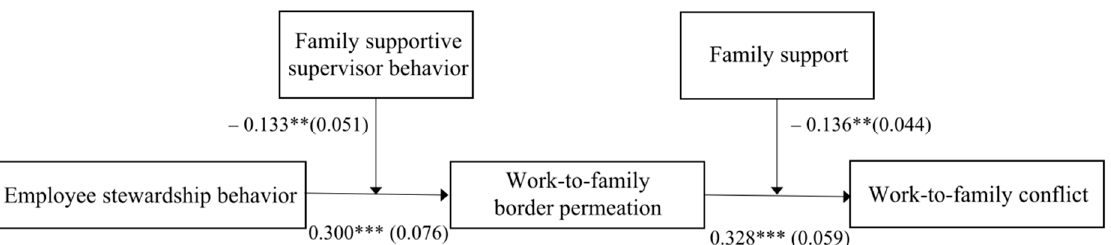
Figure 3. Interaction effect of family support.